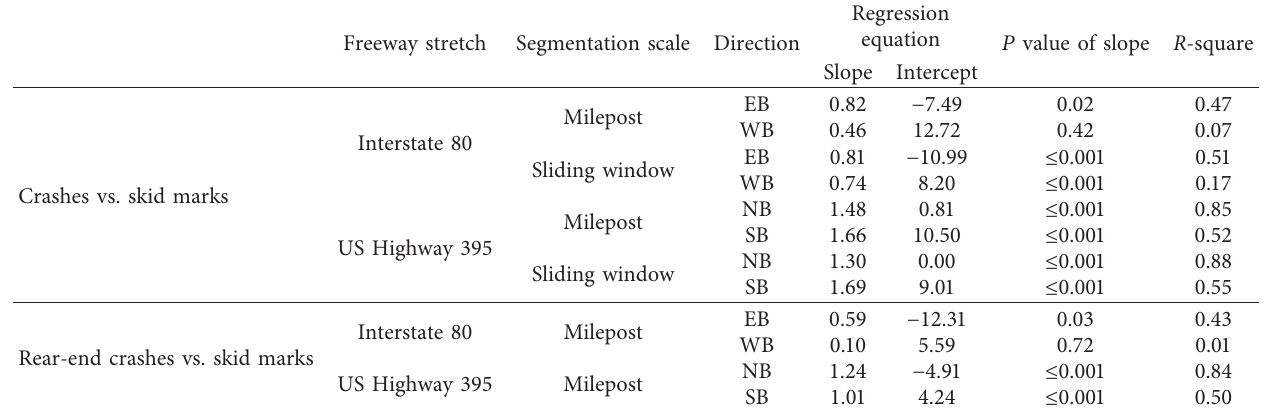
Table 5: Regression outputs for